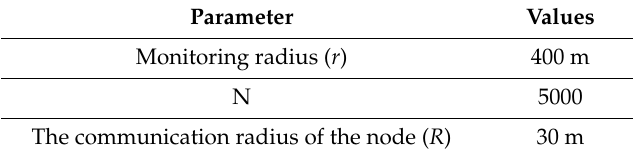
Table 1. Simulation parameters for the network connectivity and energy e ffi ciency